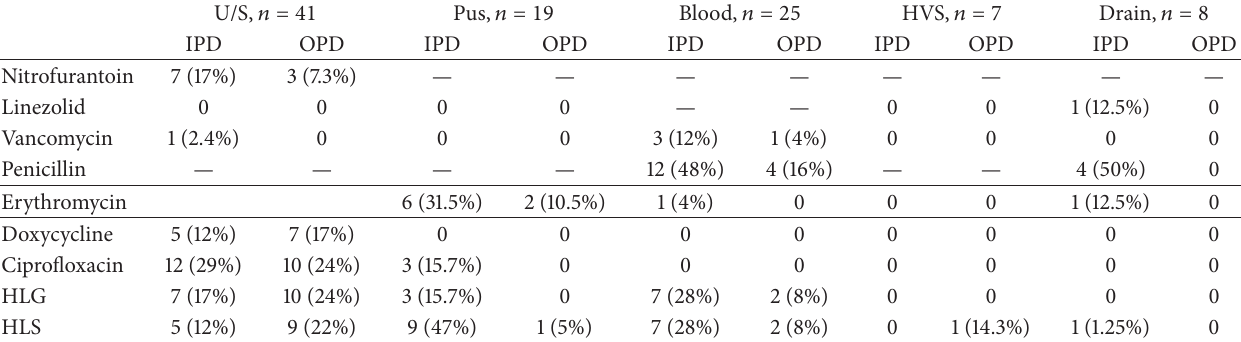
Table 3: Prevalence of antibiotic resistance in Enterococcus spp. in various clinical samples in IPD/OPD settings.